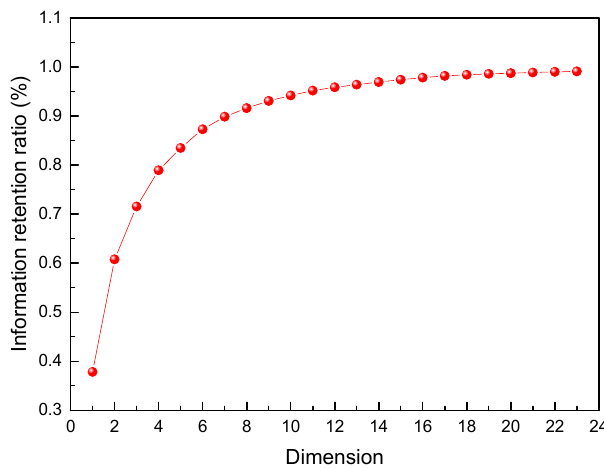
Figure 4. Information retention ratio.